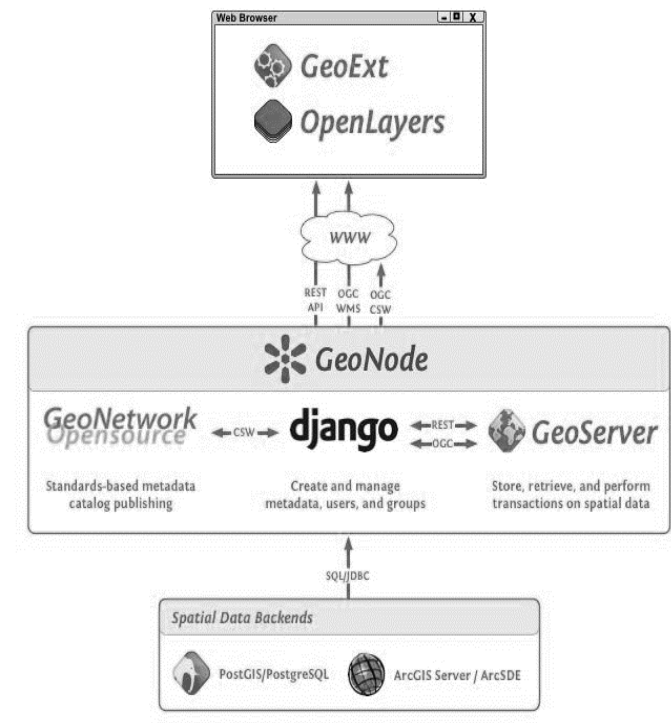
Fig. 2 : Top-down development structure for open